Question: What direction does the quantity move in — increasing or decreasing?
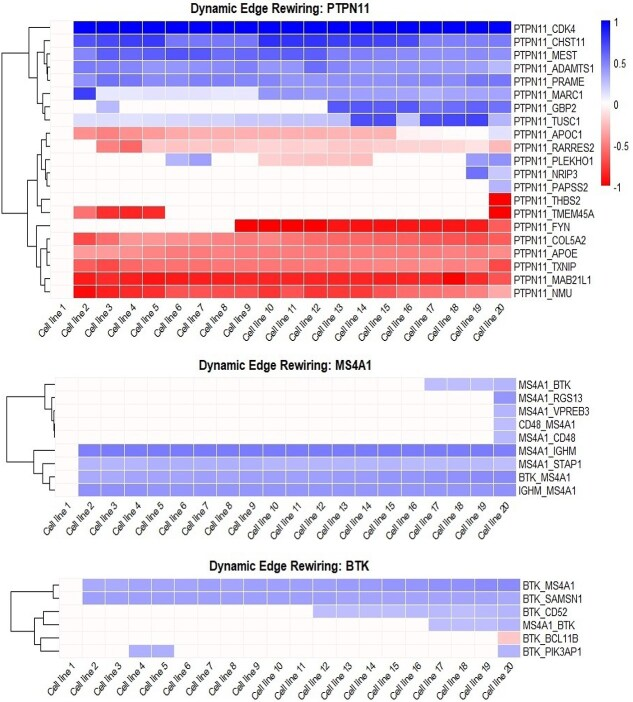
Answer: increasing